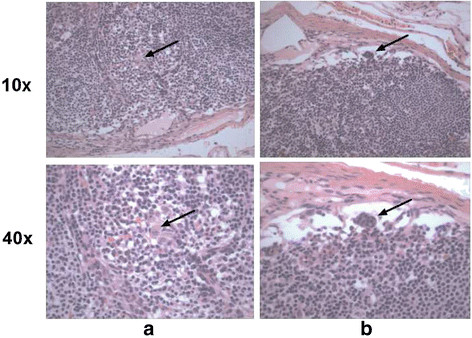
Suspicious “tumor” cell clusters in lymph nodes that are negative for tumor metastasis on examination after H&E staining but positive for CgA RNA after PCR of lymph node tissue. The arrows point to suspicious minute cell clusters in case (3a) and (3b), shown under lower and higher magnification.